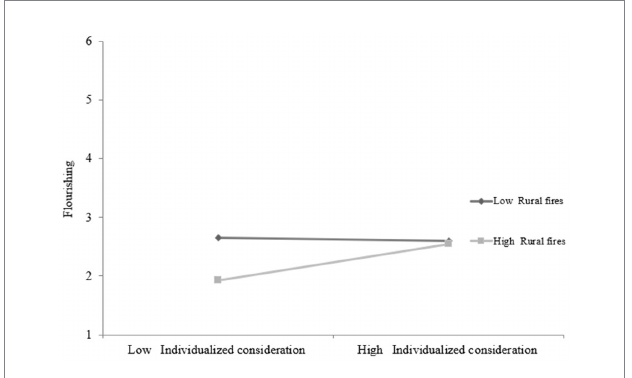
FIGURE 1 Representative graphic of the interaction between Individualized consideration and Rural fires, and its effect on